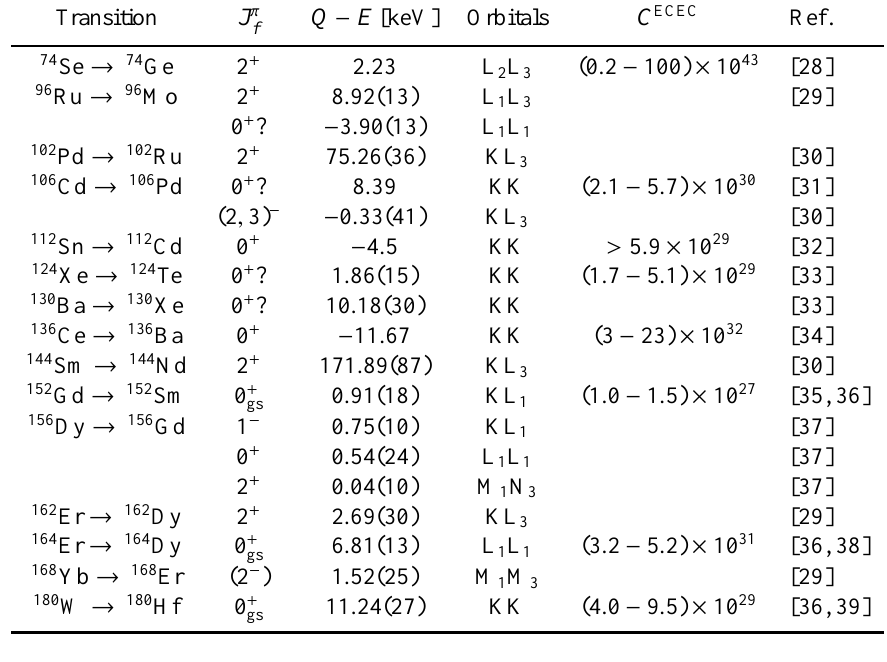
Table 2. R0 ν ECEC decay transitions with the final-state spin-parity indicated in the second column and the degeneracy parameters Q − E in the third column. The involved atomic orbitals have been given in the fourth column. The second last column lists the currently available half-live estimates with the references to the Q -value measurement and calculations indicated in the last